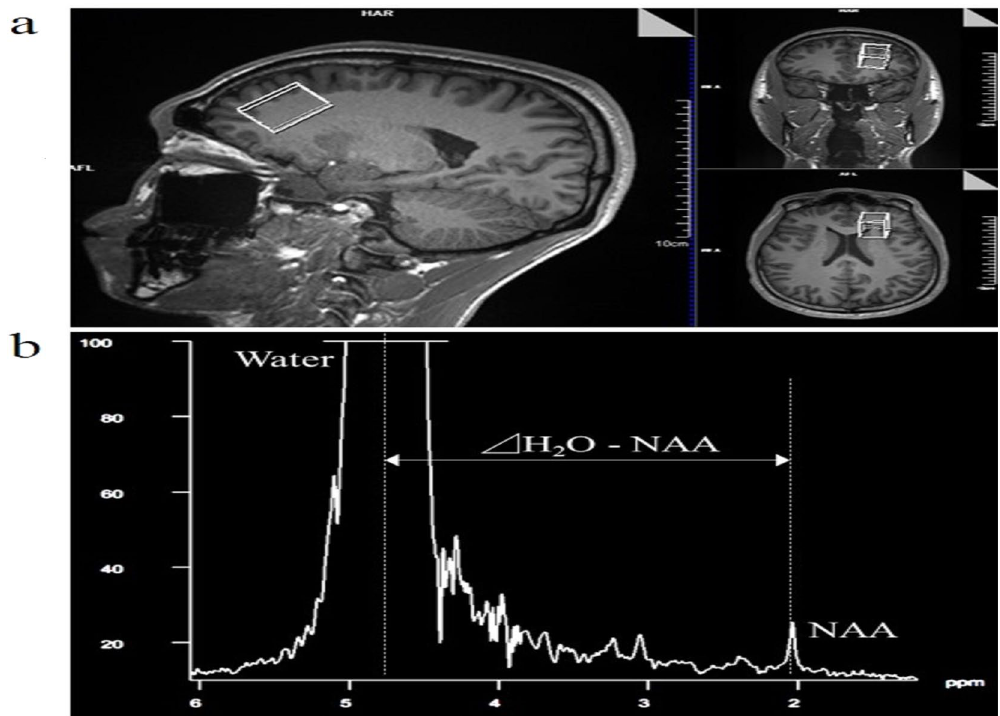
Figure 1. Magnetic resonance spectroscopy. ( a ) Magnetic resonance spectroscopy images of the frontal cortex of interest identified on three-dimensional T1 images. ( b ) An example of the estimation of brain temperature using chemical shift between water and water-N-acetyl aspartate